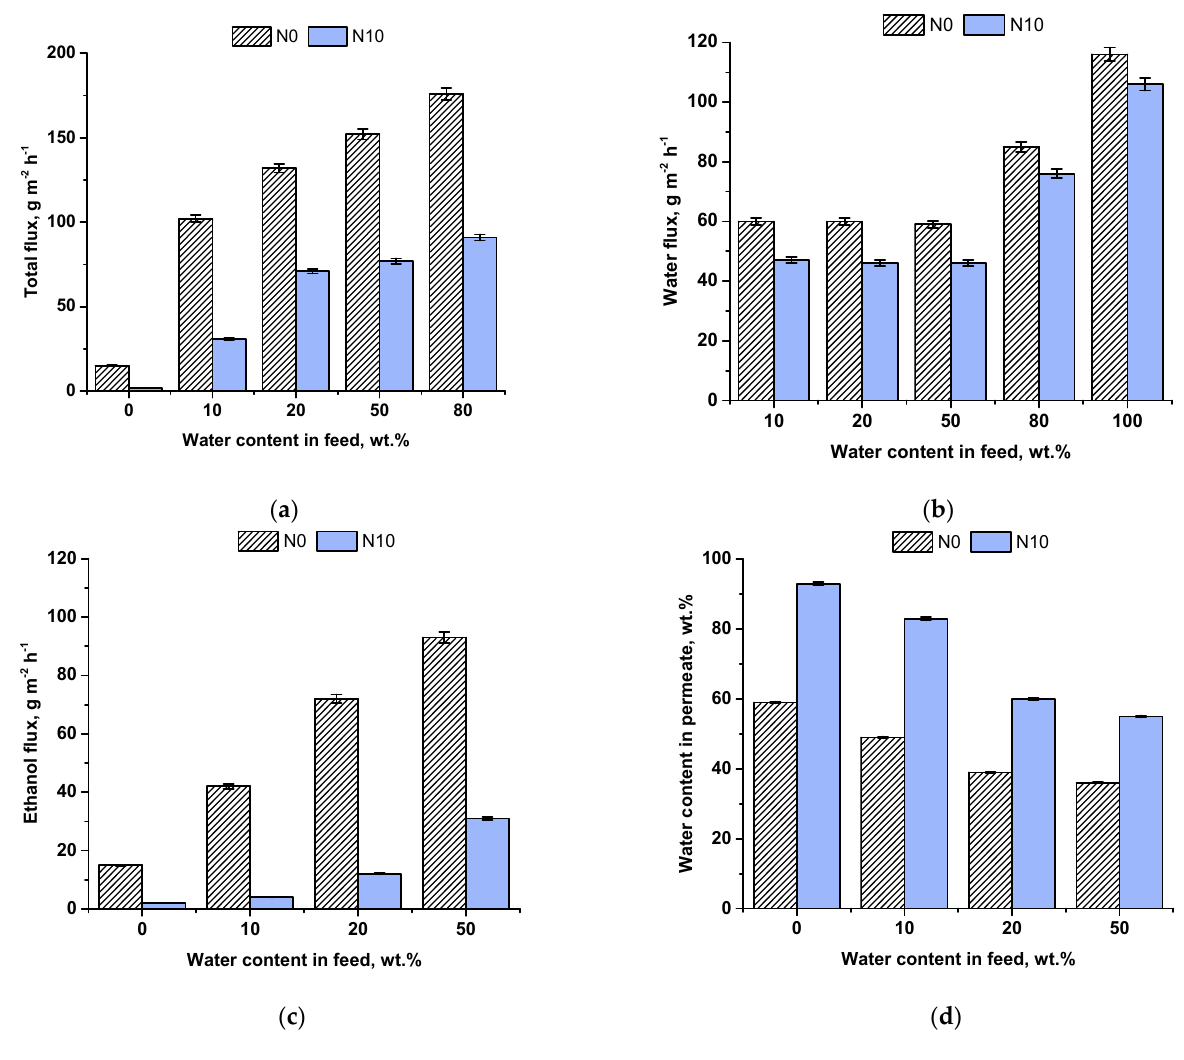
Figure 6. Dependence of total flux ( a ), water ( b ) and ethanol ( c ) fluxes, water content in permeate ( d ) of TFC and TFN membranes on the water content in the feed solution. The pervaporation experiment with dry ethanol showed that TFC membrane N0 featured higher ethanol flux compared to TFN N10 membrane (Figure